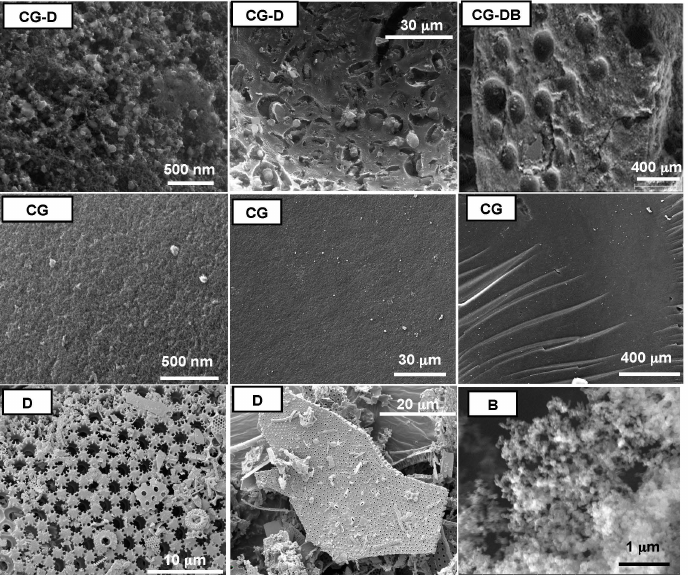
Figure 1. Scanning Electron Microscopy (SEM) images representative of the studied monolithic aerogels prepared in the presence and absence of the additives. Images of the diatomite (sample D) and the carbon black (sample B) are also shown for